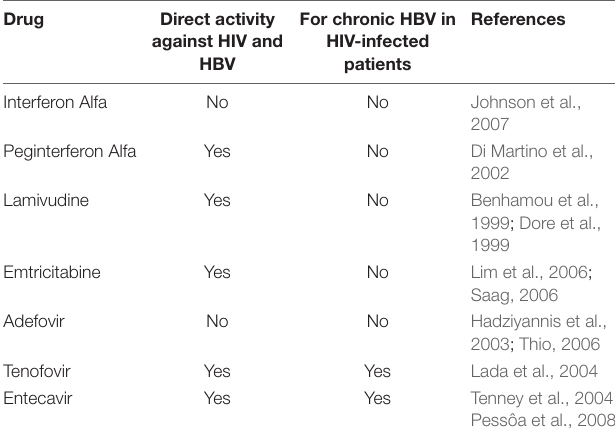
TABLE 3 | Potential medications and their activity against HIV-HBV coinfected individuals.